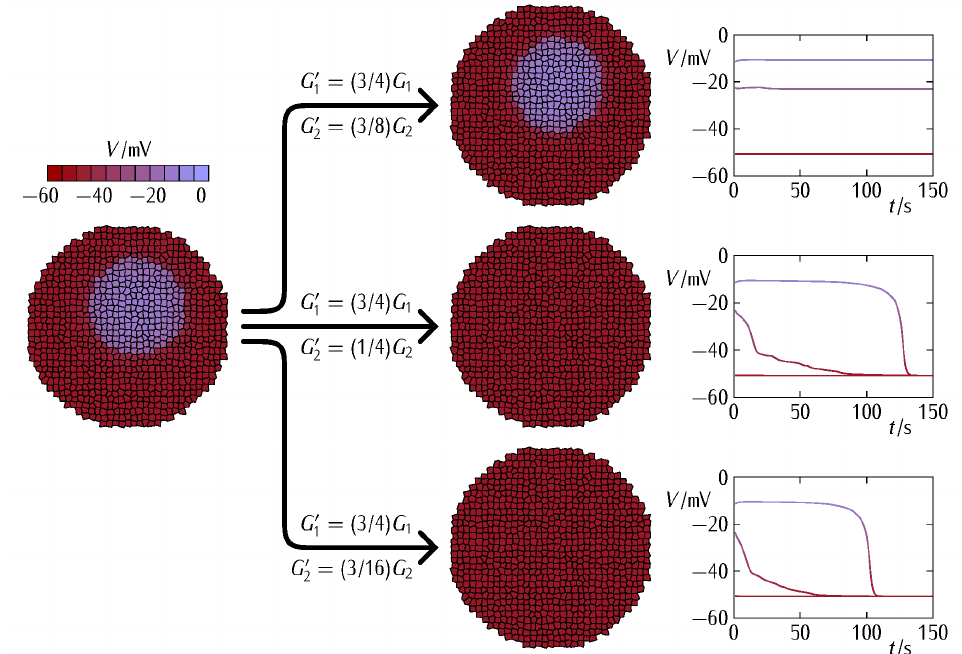
Figure 4. The cell system changes due to a decrease in the conductances G 1 and G 2 to the new values G (cid:48) (fixed decrease) and G (cid:48) (three different decreases) shown in the figure ( left ). The community effect 2 1 within the depolarized patch can still resist the polarization by the surrounding bulk region if the G 2 decrease is small ( left , top ). Thus, a minimum decrease of G 2 is needed to weaken the community effect within the patch enough to be polarized ( left , intermediate ). Further decreases in G 2 ( left , bottom ) only cause faster patch polarizations, as shown by the electrical potential changes in three cells located at the patch, the surrounding bulk, and the interfacial region ( right ). The single-cell maximum = G o = 1.4 G o = 1 nS. conductances assumed in Equations (1) and (2) are G o and G o , with G o pol ref dep ref ref For the case of isolated cells, these conductances give the stable polarized and depolarized potentials V pol (cid:39) − 50 mV and V dep (cid:39) − 10 mV, respectively [39,47]. The ratio between the initially depolarized patch area and the whole system area is